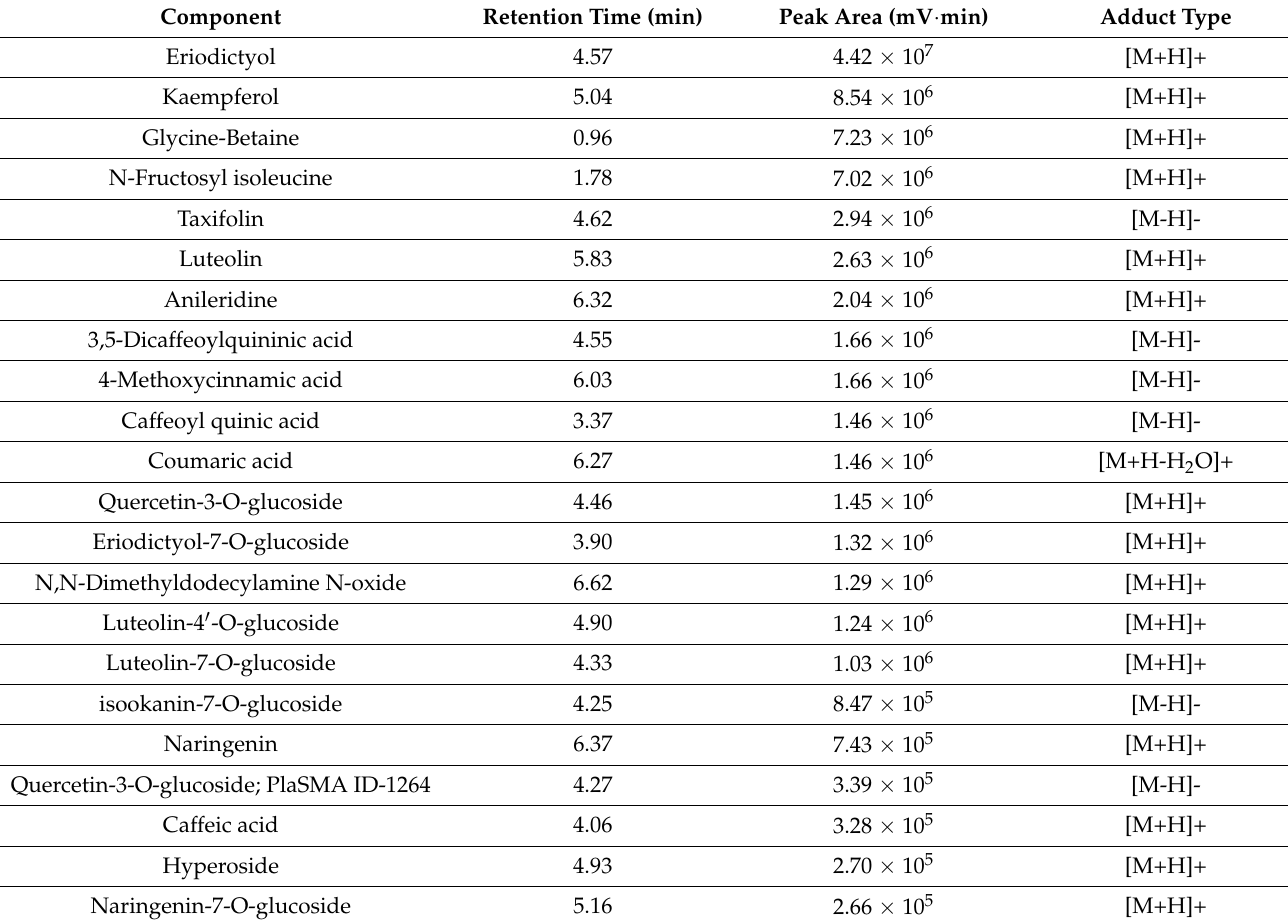
Table 1. Components of C. tinctoria